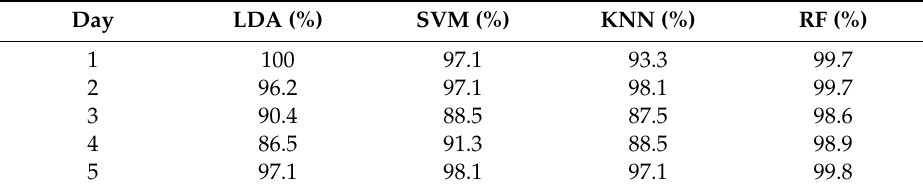
Table 3. Sensor stability analysis for eight black teas and five green